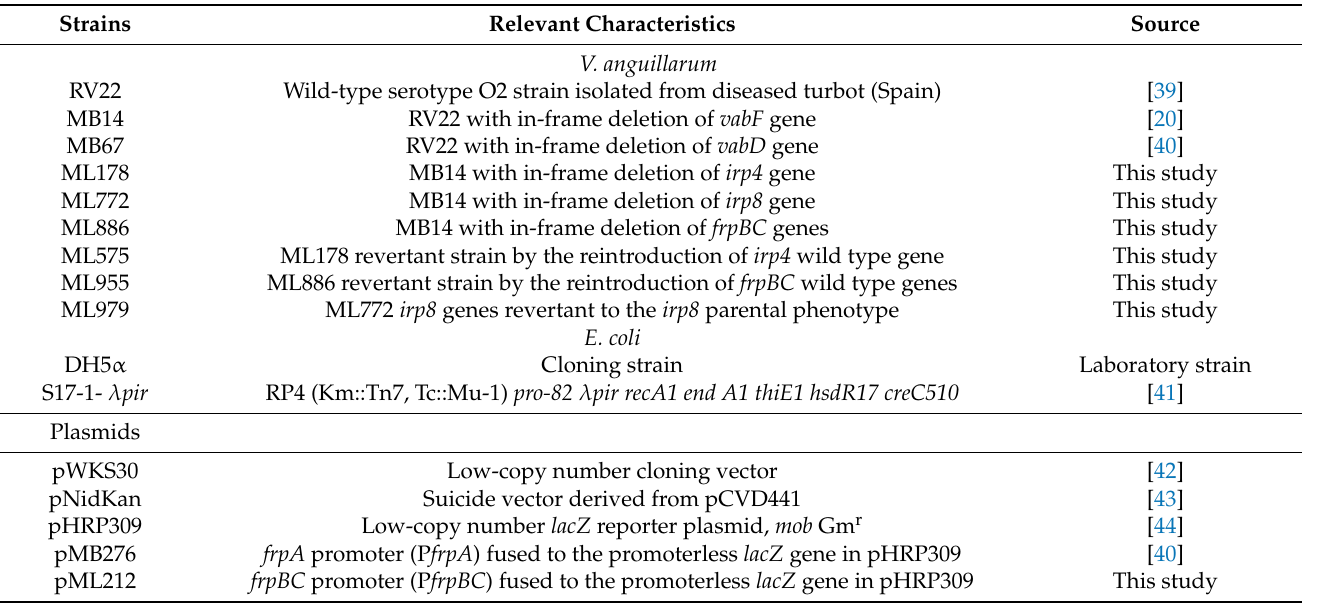
Table 1. The bacterial strains and plasmids used in this